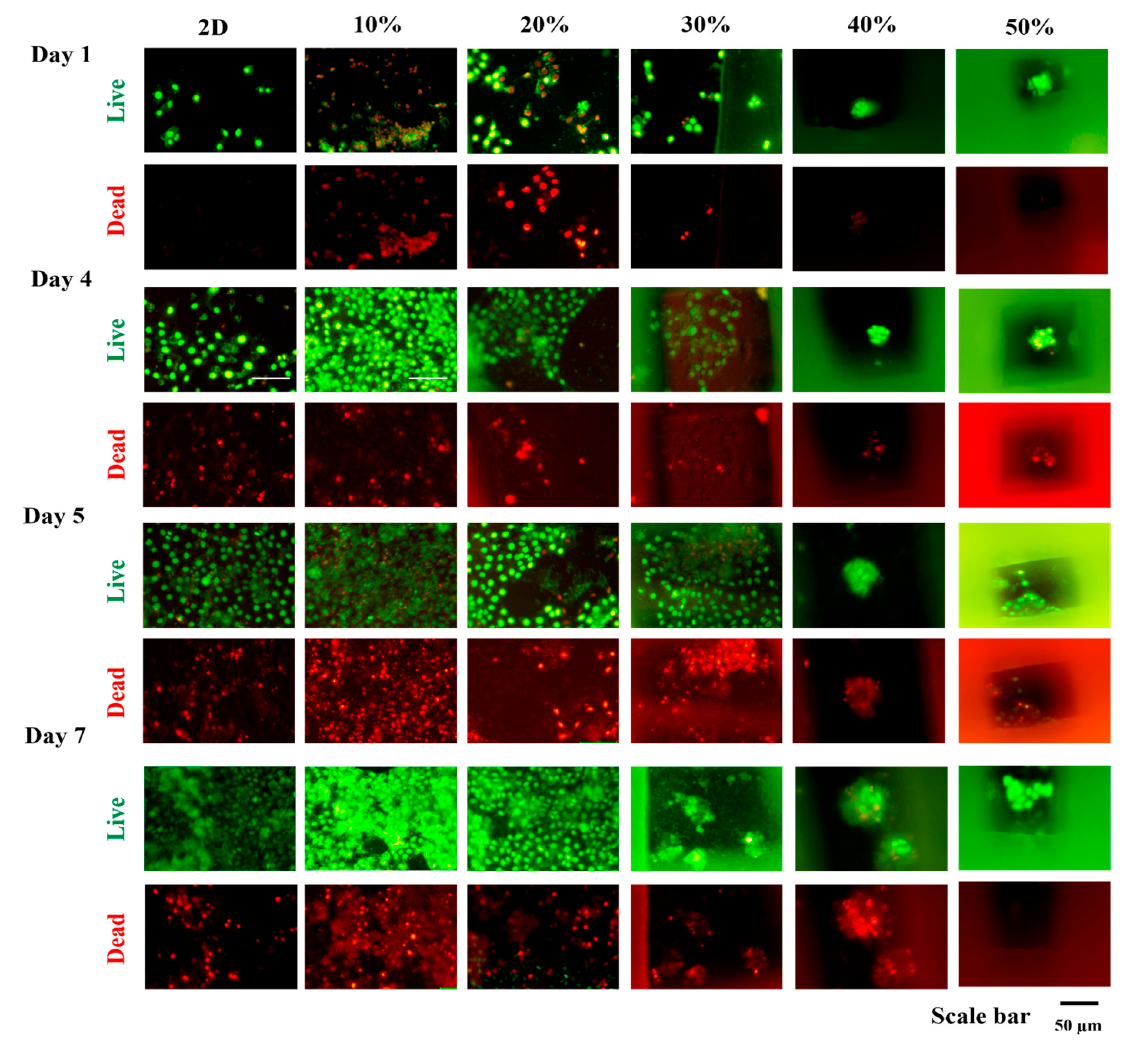
Figure 3. Live / Dead staining of keratinocytes human keratinocyte cells (HaCaT) cells cultured in three-dimensional printed industrial acrylonitrile butadiene styrene scaffold printed with different infill densities ranging from 10% to 50%. Cells were seeded at 5 × 10 4 cell/mL; scale bar: 50 µm.